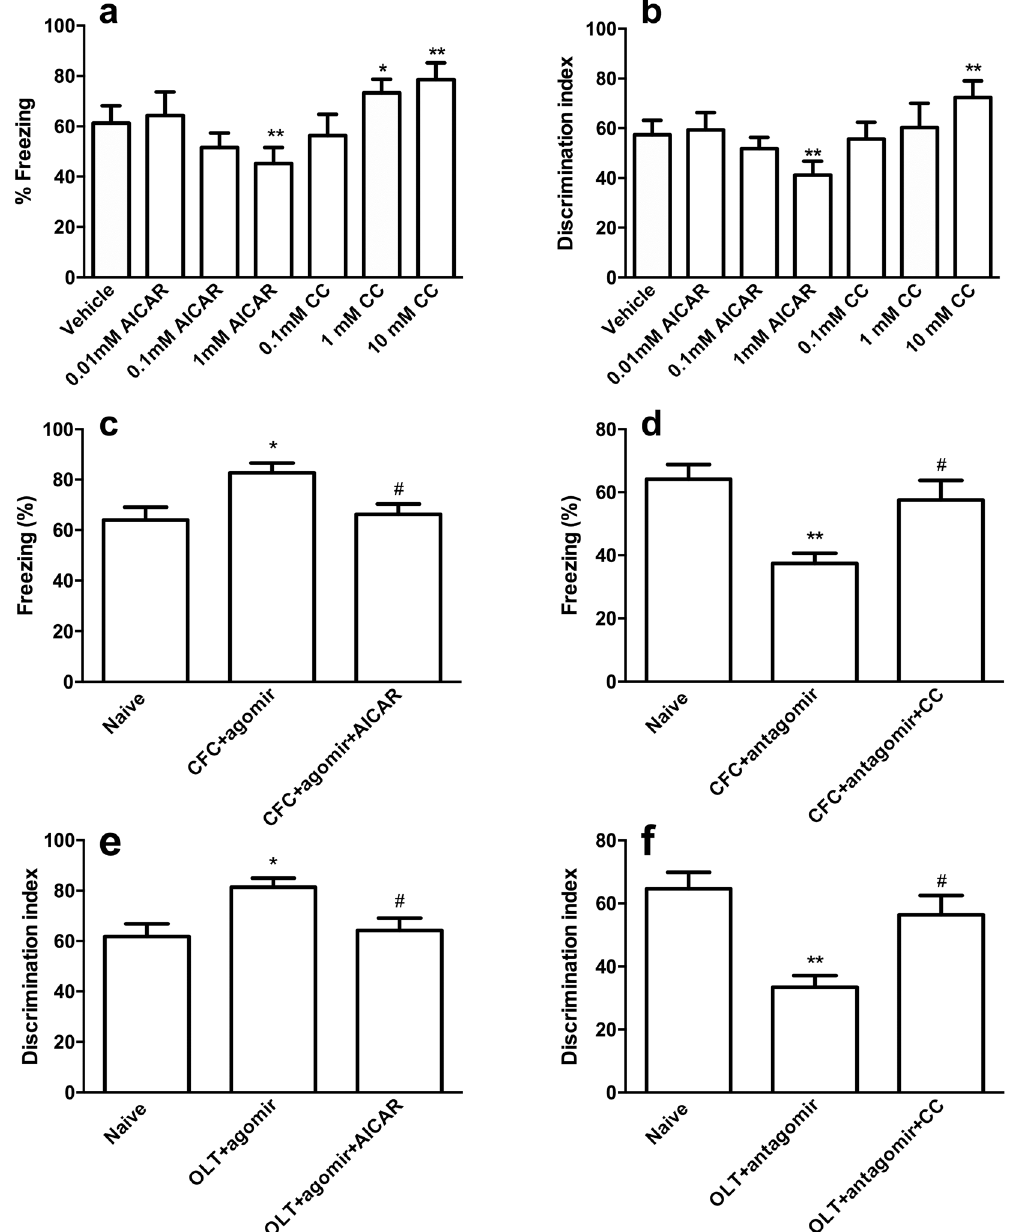
Figure 6. miR-181a was involved in LTM formation following CFC and OLT by regulating PRKAA1. ( a,b ) Effects of different doses of the PRKAA1 agonist and inhibitor on the freezing response ( a ) and discrimination index ( b ) of mice 24 h after CFC or OLT training. * p < 0.05, ** p < 0.01, compared with the vehicle group. n = 7 per group. ( c – d ) Freezing response when tested 24 h after CFC training. * p < 0.05, ** p < 0.01, compared with the naïve group. # p < 0.05, compared with the CFC + miR-181a agomir group or CFC + miR-181a antagomir group. ( e – f ) Discrimination index 24 h after OLT training. * p < 0.05, ** p < 0.01, compared with the naïve group. # p < 0.05, compared with the OLT + miR-181a agomir group or OLT + miR-181a antagomir group. CC, compound C. n = 8 per group. All values are presented as means ±